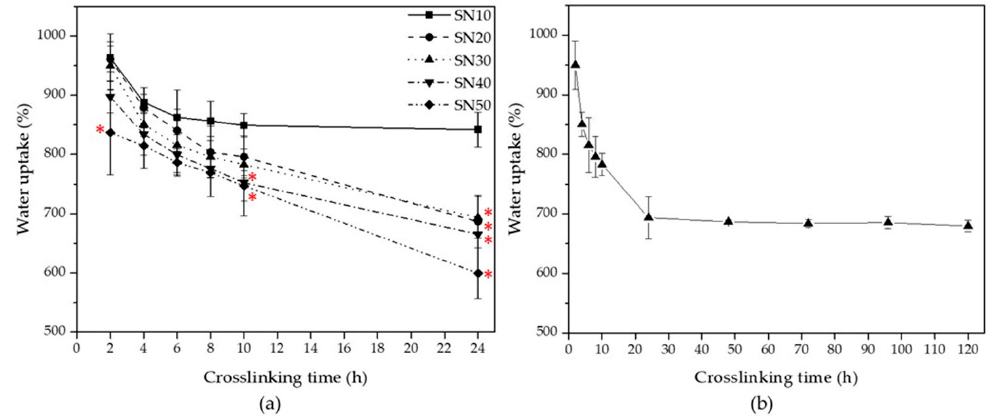
Figure 5. Water uptake of SN starch hydrogels; ( a ) various crosslinking times and GA contents ( n = 3, * p < 0.05 compared with SN10) and ( b ) SN30 at various crosslinking times from 2–120 h.